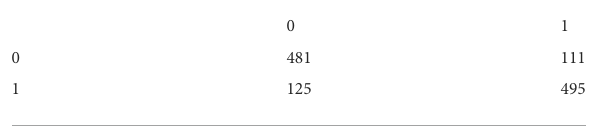
TABLE 4 Confusion matrixes for Machine Learning models.